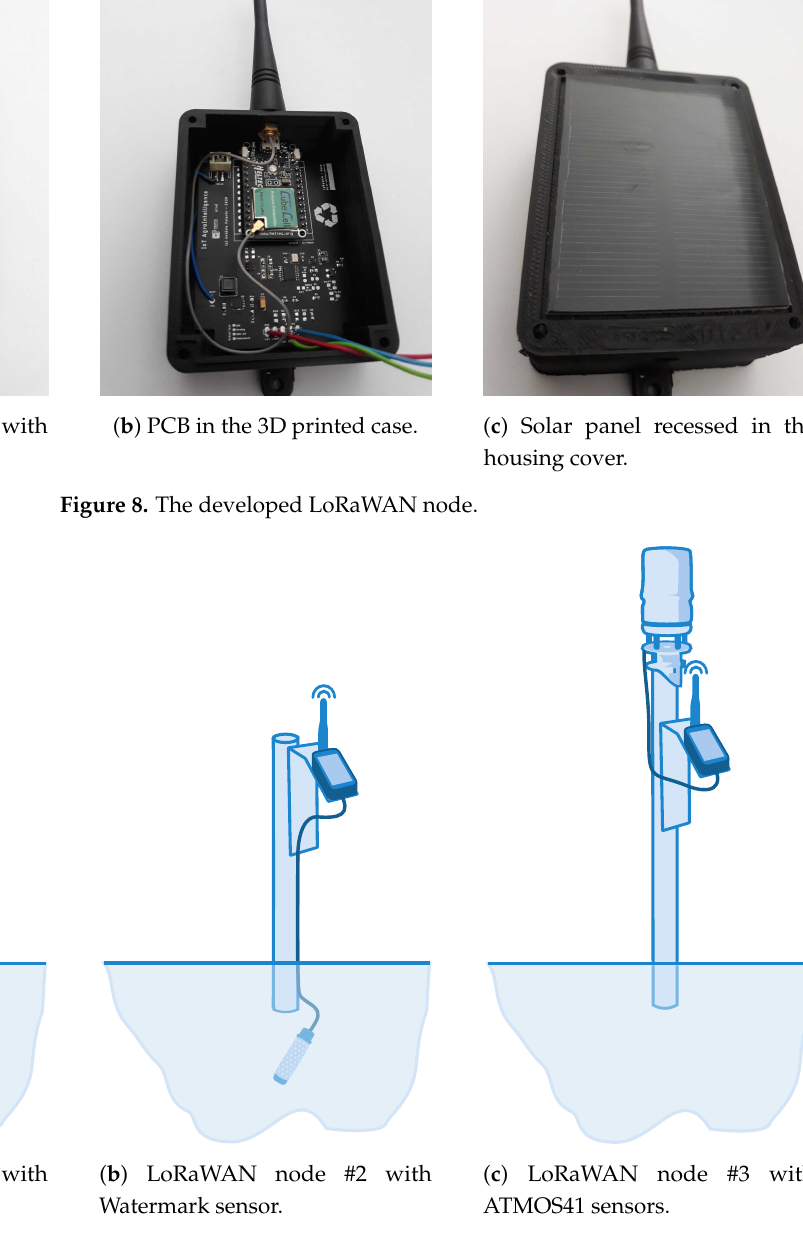
Figure 9. The experimental